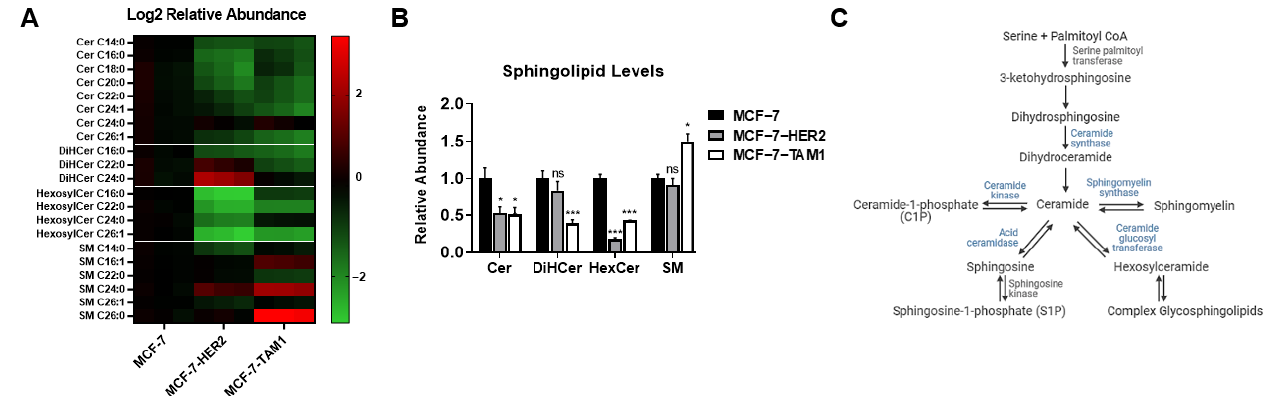
Figure 1. Targeted analysis of the sphingolipidome reveals decreased ceramides and hexosyl- ceramides in tamoxifen-resistant cells. ( A ) Abundance of different sphingolipid species in tamoxi- fen-resistant MCF-7-HER2 and MCF-7-TAM1 cells relative to tamoxifen-sensitive parental MCF-7 cells was determined by LC-MS. Relative abundances in log2 scale are presented as a heatmap. Rel- ative abundances were calculated by dividing the abundance of a certain sphingolipid species by the average abundance of that species in MCF-7 cells. ( B ) Relative abundance of total ceramides (Cer), dihydroceramides (DiHCer), hexosylceramides (HexCer), and sphingomyelins (SM) in each tamoxifen-resistant cell line were calculated by dividing the abundance of a certain sphingolipid species by the average abundance of that species in MCF-7 cells and are presented as fold changes in a bar plot. ( C ) Simplified version of the human sphingolipid pathway is presented as a schematic diagram. Key enzymes in the pathway are shown in blue. ns: not significant, * p < 0.05, *** p < 0.001.